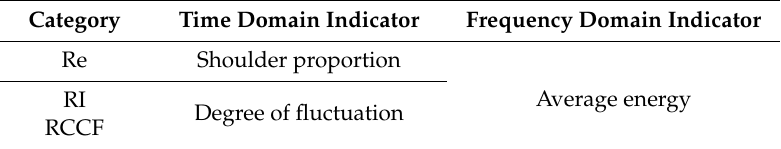
Table 3. Selection of load indicators and comparison of characteristics.